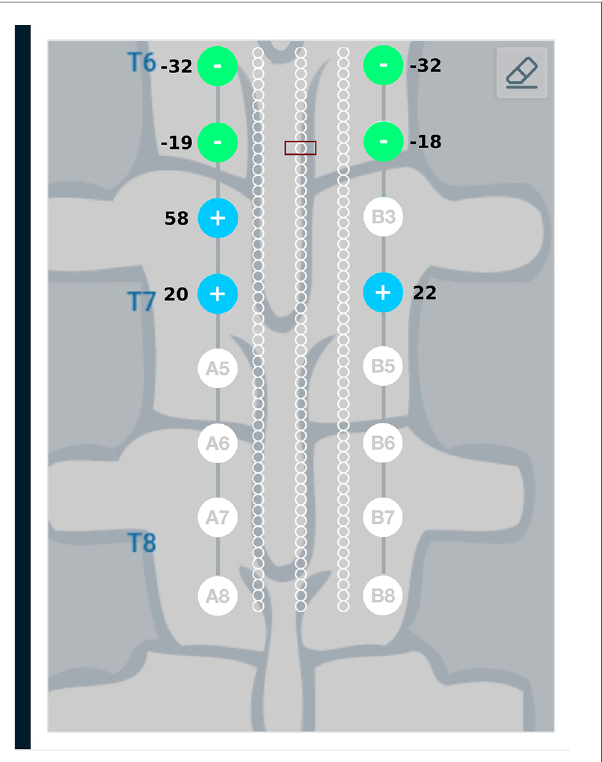
FIGURE 9 Current steering results graphically represented on the user interface. The current steering results are shown for 2-sided current sources with electrode B3 assumed to be disconnected — the current steering solution gives the optimum electrode excitation pattern without using B3 as an active electrode. In comparison to Figure 8 , we can observe that more current is sourced from electrode A3 to compensate for B3 as a fl oating